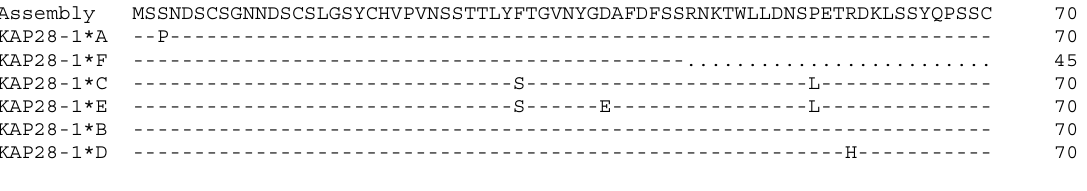
Figure 4. Alignment of the ovine KRTAP28-1 variant sequences together with the ovine genome assembly sequence. Eight single nucleotide polymorphisms and a dinucleotide repeat polymorphism were detected in ovine KRTAP28-1 . Nucleotides in the coding region are presented in upper case letters and those in the non-coding regions are in lower case. Dashes designate nucleotides indistinguishable to the ovine assembly, and dots have been introduced to increase the alignment. A putative TATA box is shaded, and the start and stop codons are presented in bold. The TG dinucleotide repeat region is boxed, and the horizontal lines designate the primer binding regions. Assembly